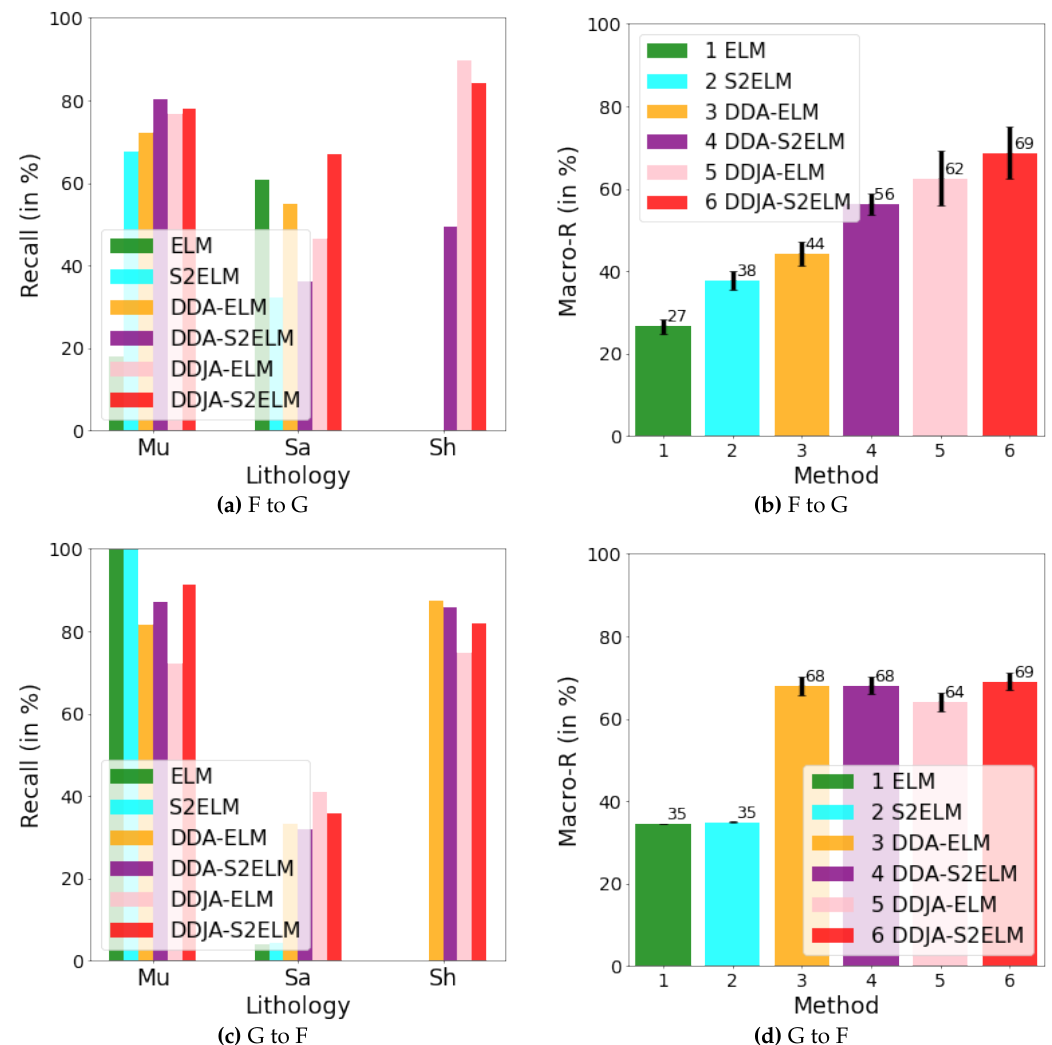
Figure 6. The results of performing our method on dataset 3. In ( a ) and ( b ), we show the recalls for the classes of Mu, Sa, and Sh and their macro average recall by transferring F to G. In ( c ) and ( d ), we show those by transferring G to